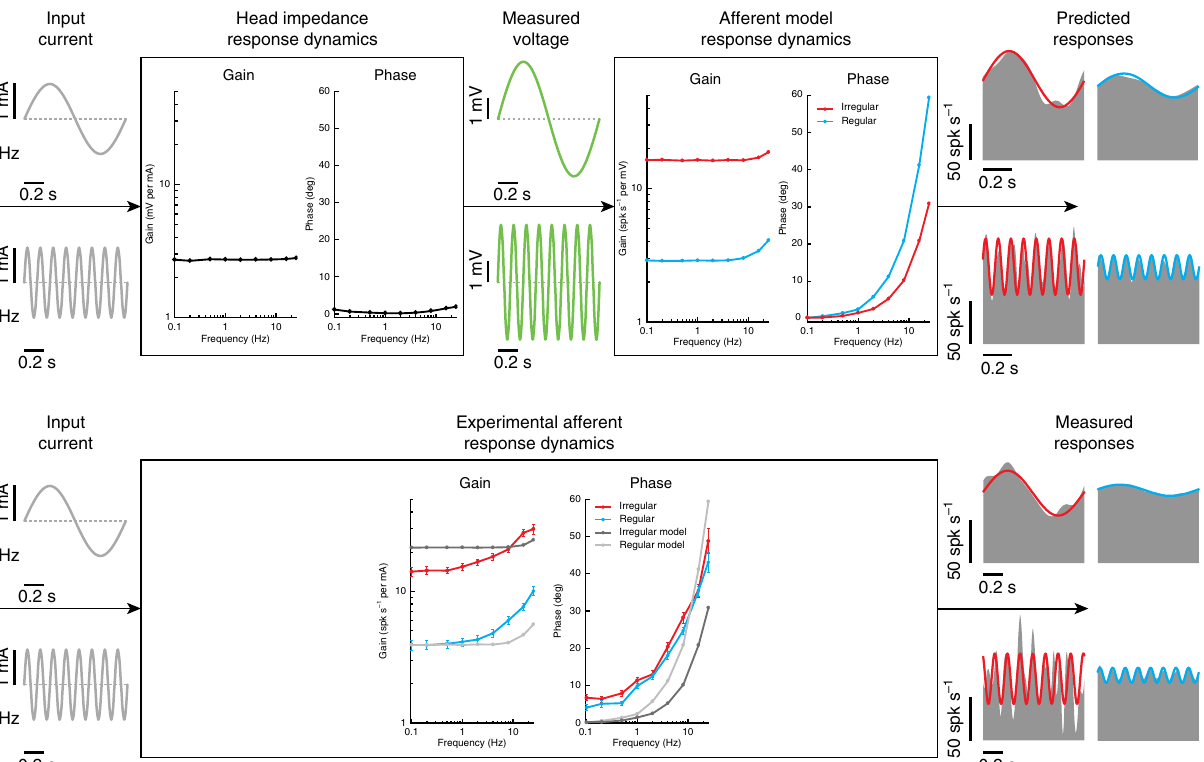
Fig. 6 Simulation results of a vestibular afferent model to galvanic vestibular stimulation. a Current input (gray) produces voltage changes (green) in the tissue surrounding the afferent with a fl at gain and phase at all frequencies (i.e., head impedance response dynamics — left box). These voltage changes were then used as input to the afferent model to produce the changes in afferent fi ring rate (gray) for example regular (blue) and irregular (red) afferents. The resultant afferent model response dynamics (right box) produce increasing gains and phases as a function of frequency for both afferent types. b Experimentally estimated canal afferent response dynamics as a result of a current input are replotted here for comparison to the simulated data. Similar to the experimental responses, simulated data produced frequency dependent changes in gain and phase. For illustrative purposes simulated gain results were normalized to regular canal afferent responses at 0.1 Hz